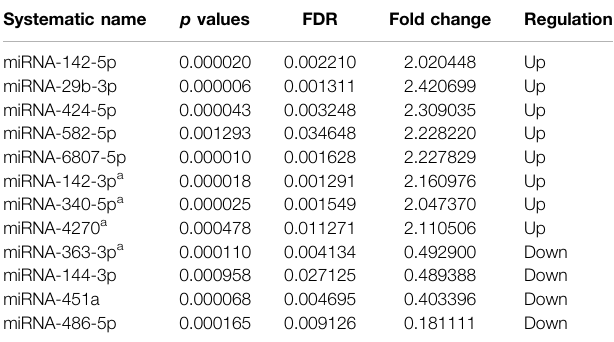
TABLE 2 | Differentially expressed miRNAs in microarray analysis between MMD patients and controls.